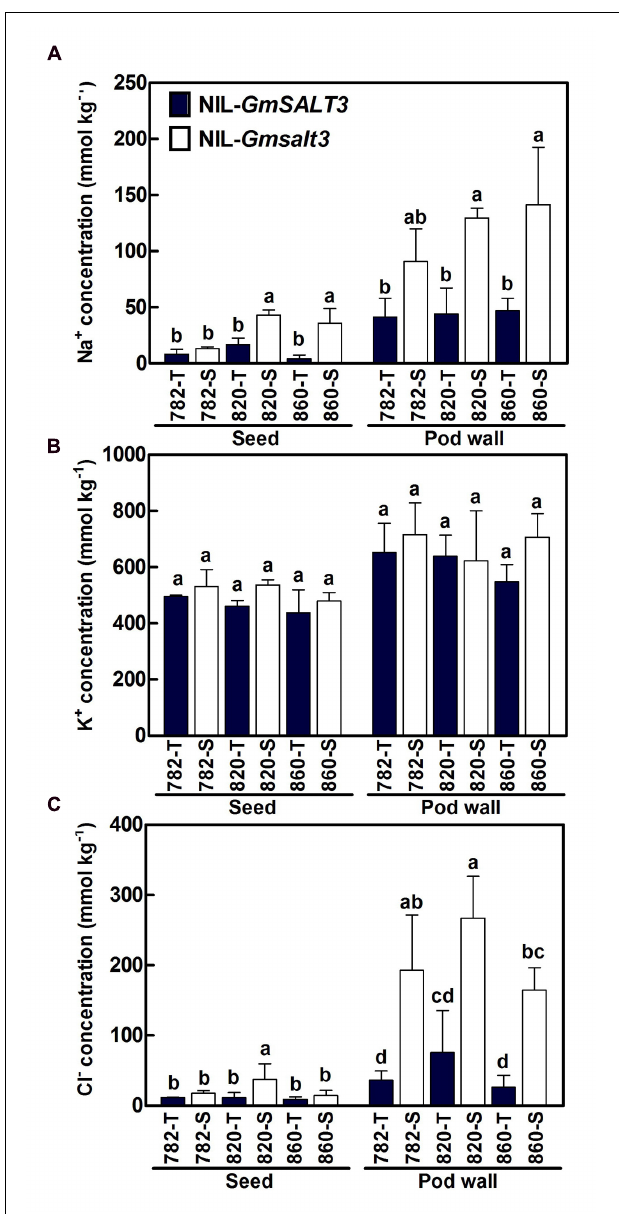
FIGURE 7 | Mean Na + (A), K + (B), Cl − (C) concentrations (dry mass) in seeds and pod walls of three sets of NILs grown on saline field (2015, Tanghai). Data are means of three replicates consisting of the mean values for 15 plants for per replicate ± SD ( n = 3). Different letters indicate statistically significant differences between NIL lines for each tissue (one-way ANOVA followed by Tukey’s HSD post hoc test, P <